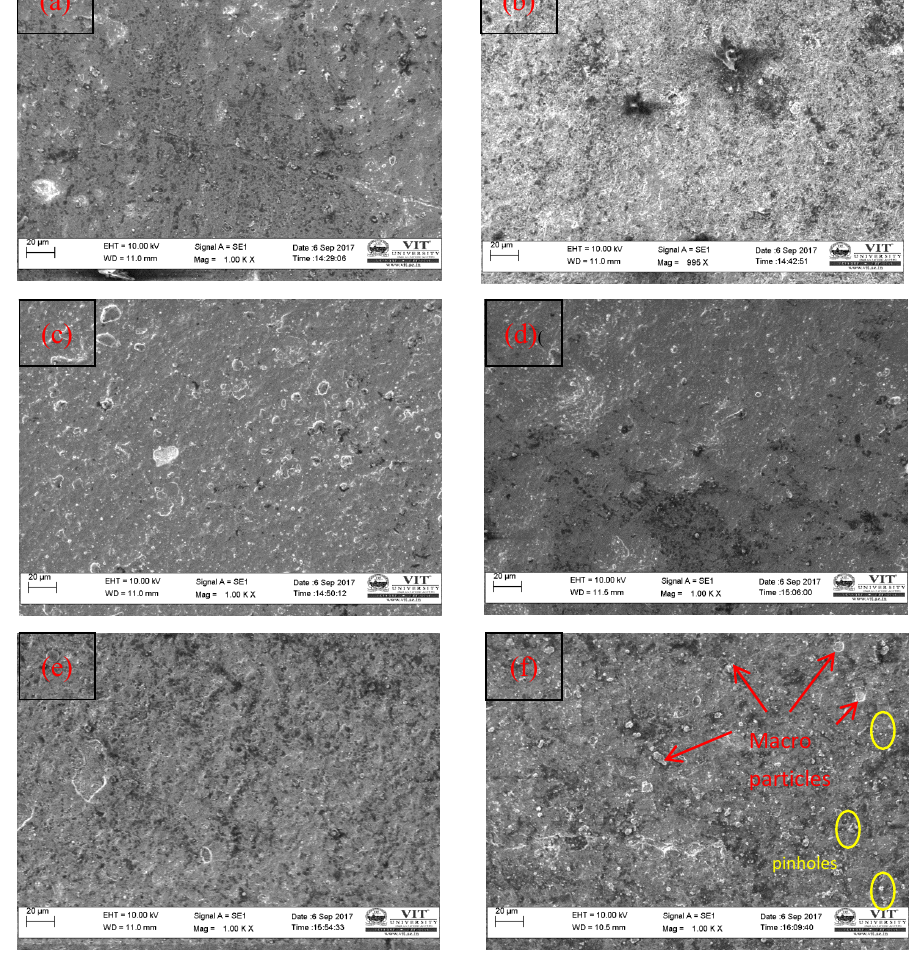
Figure 7. SEM micrographs of the coating ( a ) Fe, ( b ) Fe–2Cu, ( c ) Fe–2Cu–0.8C, ( d ) Fe–2Cu–0.8C–0.2Mo, ( e ) Fe–2Cu–0.8C–0.4Mo and ( f ) Fe–2Cu–0.8C–0.6Mo.